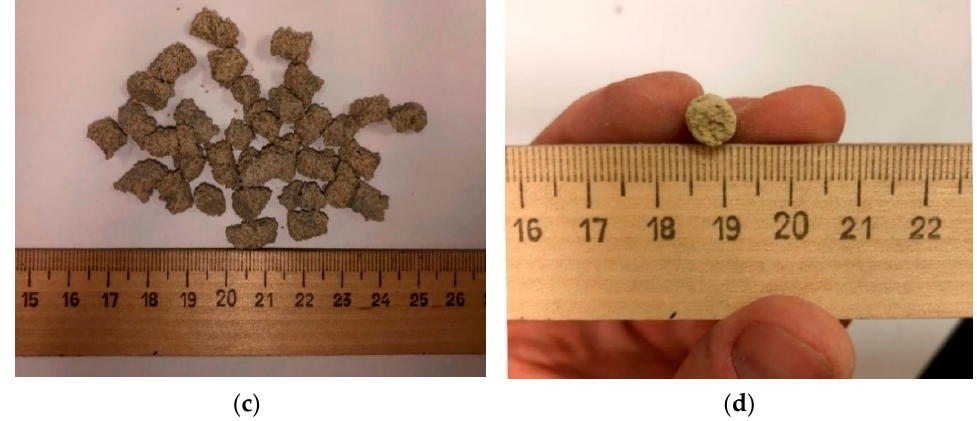
Figure 1. General view with linear dimensional units (mm) of granular aggregates (GAs). ( a ) GAs based on quartz sand with a 0.16 mm fraction and addition of 15% composite binder (CB)-2; ( b ) GAs based on quartz sand with a fraction of 0.315 mm and addition of 15% CB-2; ( c ) GAs based on quartz sand with a fraction of 0.63 mm and addition of 15% CB-2; ( d ) measuring the diameter of granular aggregates.